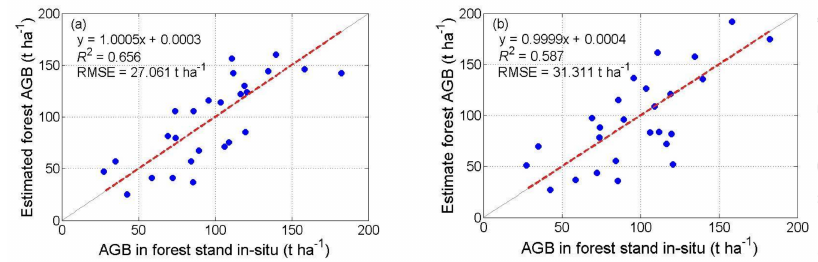
Figure 9. Forest AGB estimation results using ( a ) H ac and ( b ) TomoH in 134 deg. flight